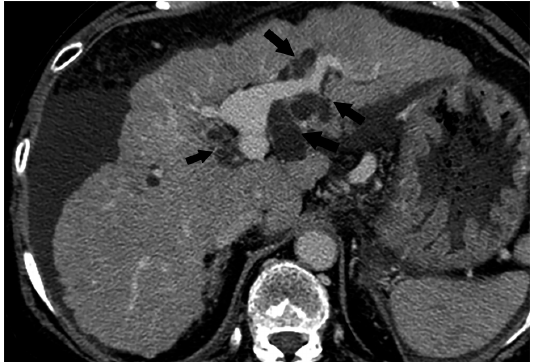
Figure 19. Peribiliary cyst observed in a 56-year-old man with cirrhosis. In the portal venous phase on contrast-enhanced CT, dilated multiple hypodense cystic structures (arrows) are observed along the left main portal vein and its branch in the hepatic hilar area. These structures are peribiliary cysts, showing cystic dilatation of the peribiliary glands around the large bile duct. Although this hypodense structure looks like intrahepatic bile duct dilatation, it is located bilaterally along the portal vein, unlike dilated bile duct